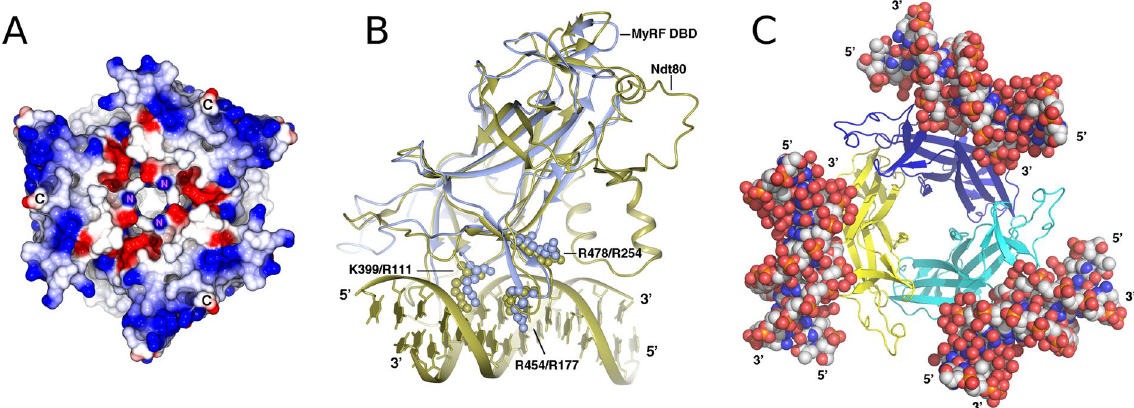
Figure 5. The electrostatic surface of MyRF DBD and the superposition of MyRF DBD with Ndt80 shows potential DNA binding region. ( A ) The electrostatic surface potential of MyRF DBD shows the electropositive region for potential DNA binding. The NH2- (N) and the –COOH ( C ) terminus of MyRF DBD are marked. ( B ) Superposition of MyRF DBD and Ndt80 shows the region that may be involved in the interaction between MyRF DBD and its target DNA. The residues K399, R454, R478 (MyRF) and R111, R177, R254 (Ndt80) are shown as a sphere model. MyRF DBD and Ndt80 colored in ice blue and gold respectively. ( C ) The modeling of MyRF DBD trimer binding with its target DNA. The DNA molecules are shown as a sphere